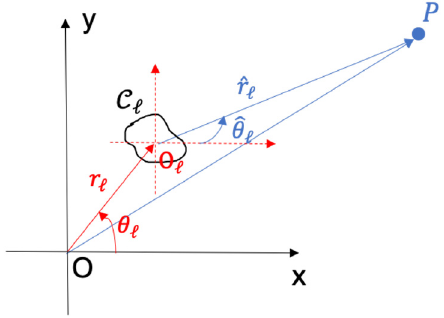
Fig. 1. Geometry sketch for the problem at